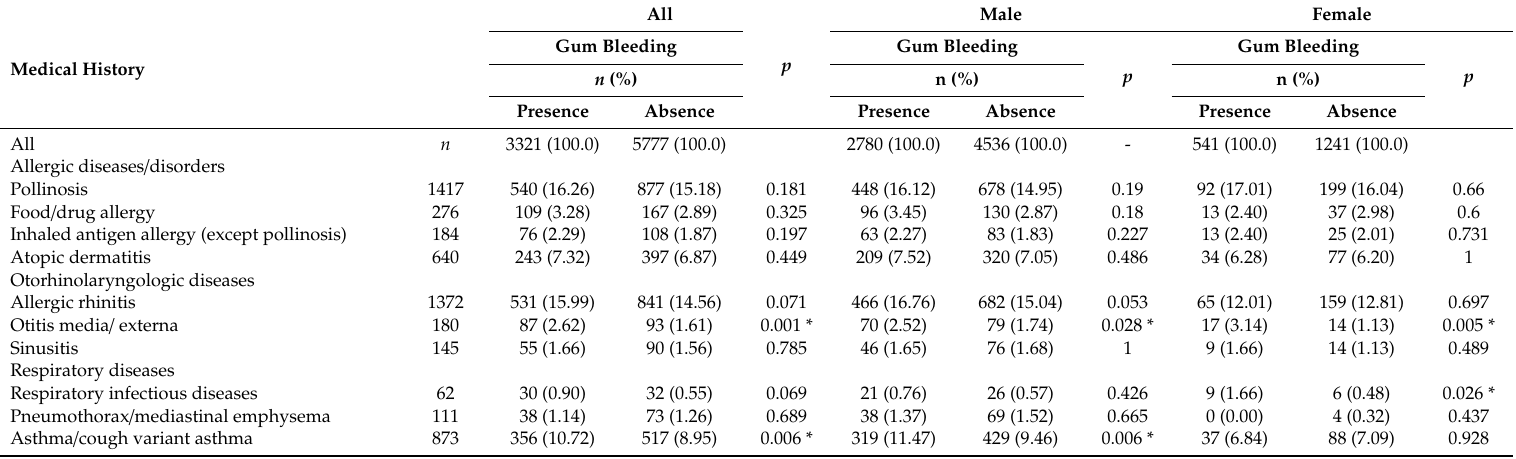
Table 2. Association between gum bleeding and medical